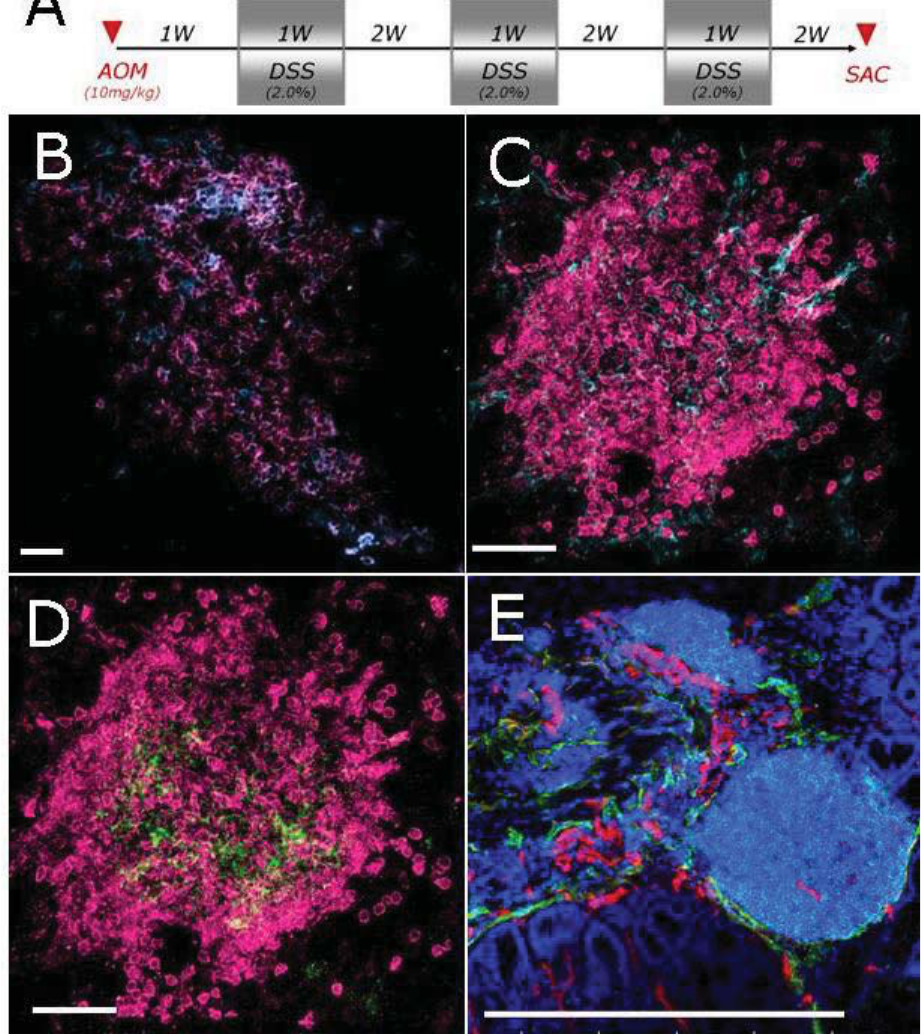
Figure 3. Characterization of lymphoid follicles in the colon of mice subjected